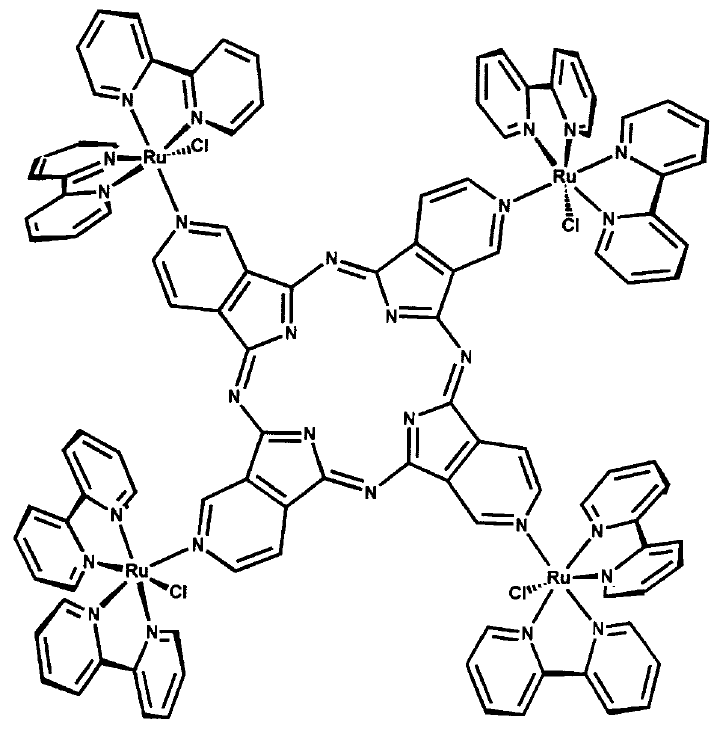
Fig. 9 – Structural representation of a tetraruthenated porphyrazine